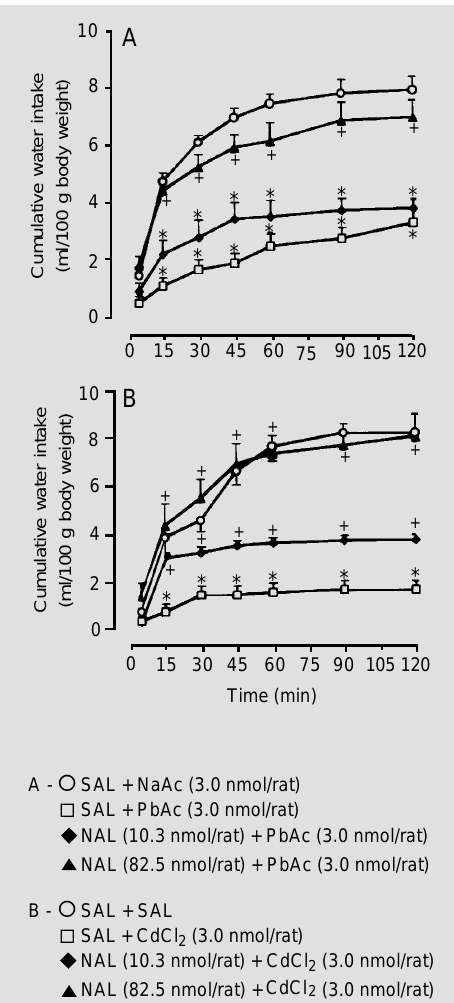
Figure 1 - Effect of third ventricle injections of naloxone on water intake in dehydrated (overnight, 14 h) rats receiving PbAc or CdCl 2 . Cumulative water intake (ml/100 g body weight) data are reported as mean ± SEM for 10 animals in each group; *P<0.01 compared to saline + NaAc group (A) or saline + saline group (B). + P<0.01 compared to saline + PbAc group (A) or saline + CdCl 2 group (B) (repeated measures ANOVA followed by Scheffé test). SAL, Saline; NAL,